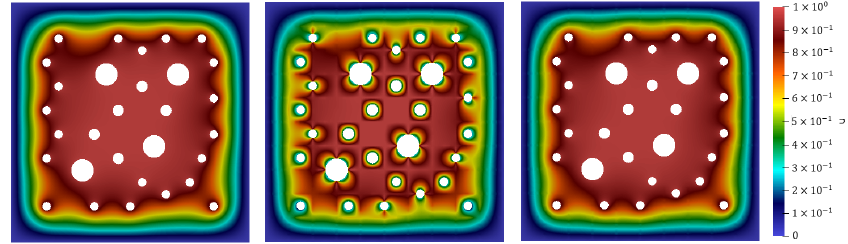
Figure 10. Elliptic problem with α = 100. Case 2 (non-homogeneous boundary conditions). Left: Reference solution ( DOF h = 85,230). Center : Multiscale solution with 12 multiscale basis functions without perforation basis functions, e L 2 = 21.52 ( M g = M = 12, M p = 0, DOF H = 1300). Right: Multiscale solution with 12 multiscale basis functions with perforation basis functions, e L 2 = 0.772 ( M g = M p = M = 12, DOF H =